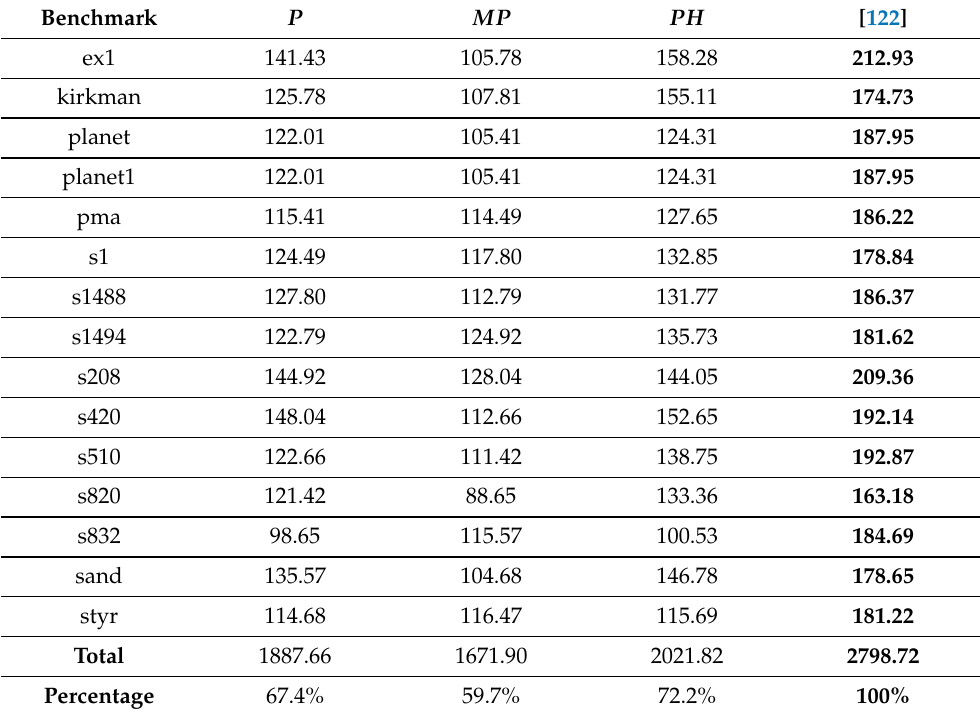
Table 14. Experimental results [122] (the operating frequency,